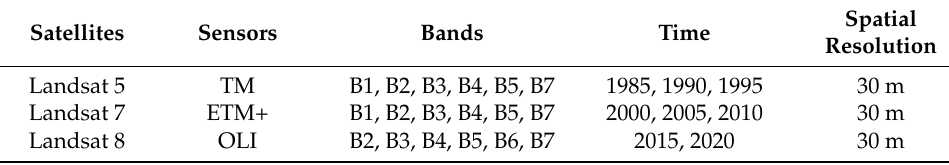
Table 1. The information of Landsat images used in this study.